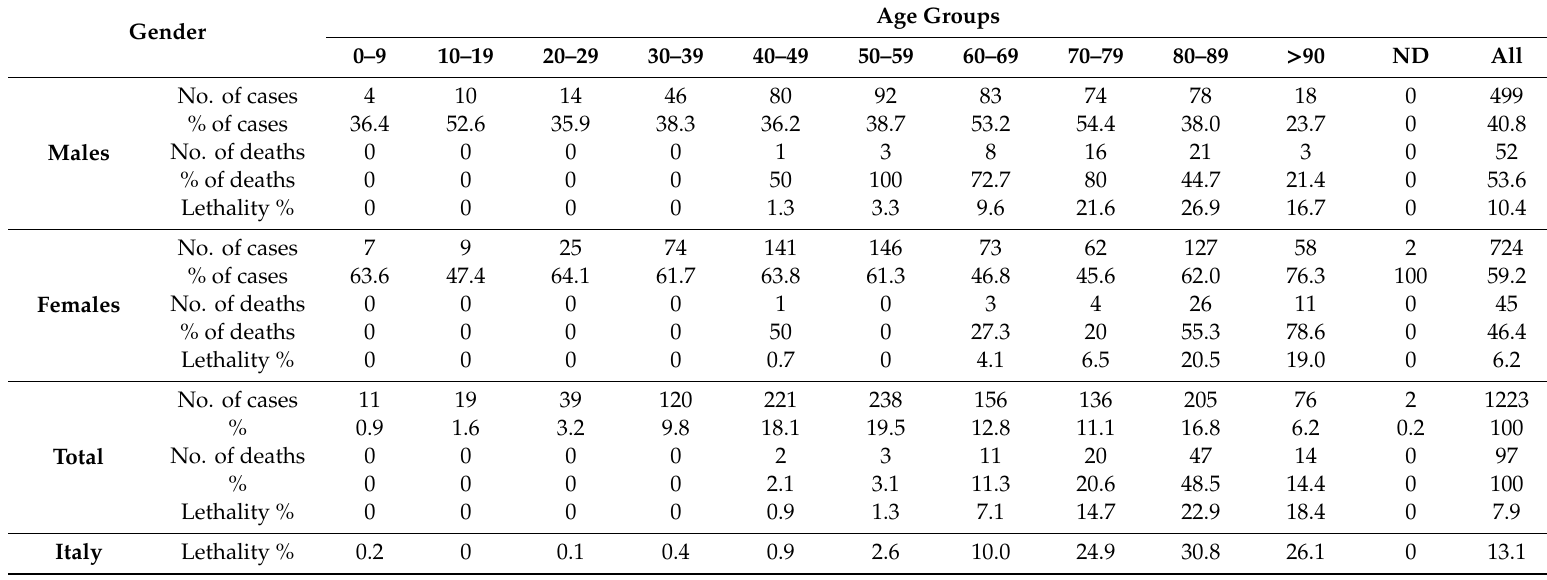
Table 1. Distribution of diagnosed cases and reported deaths with SARS-CoV-2 in Sardinia by age group and gender in respect to lethality in Italy. Gender